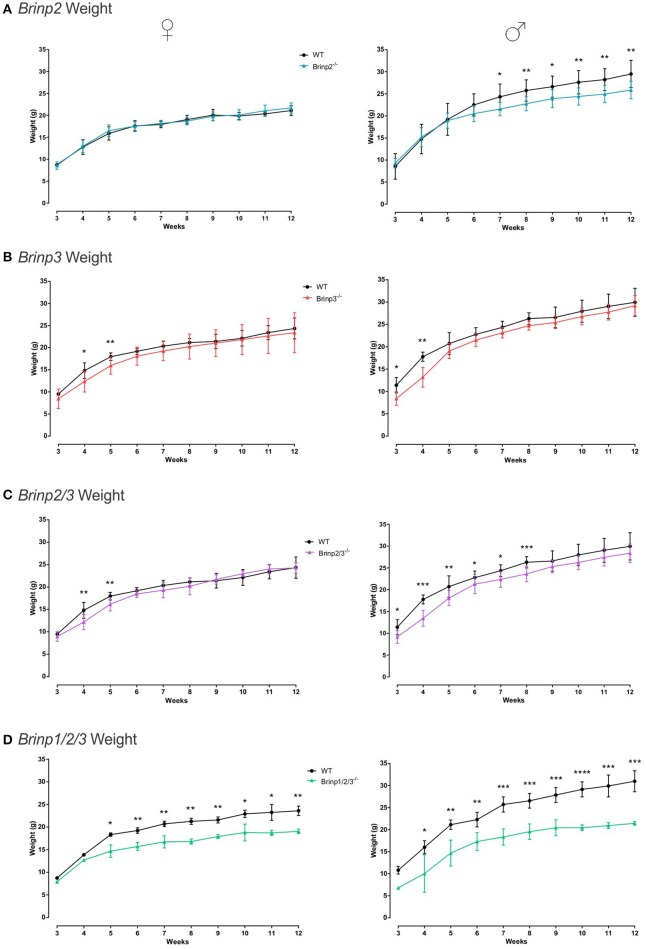
Brinp2, Brinp3, Brinp2/3, and Brinp1/2/3 weights. (A)
Brinp2−/− mice weighed from week 3 to 12. Female Brinp2−/− mice show normal weight between 3 and 12 weeks by repeat measures two-way ANOVA: F(1, 15) = 0.155, p = 0.699. Male Brinp2−/− mice show a significant reduction in body weight from 6 weeks of age onwards. By repeat measures two-way ANOVA male Brinp2−/− mice show a significant interaction of genotype × week: F(9, 117) = 5.645, p < 0.001. N = 8 females, 8 males per genotype. (B)
Brinp3−/− mice weighed from week 3 to 12. Both Male and Female Brinp3−/− mice show reduced body mass from weeks 3 to 5, before recovering to near normal weight from week 6 onwards. Female Brinp3−/− mice show a significant interaction of genotype × week: F(8, 96) = 2.115, p = 0.042, repeat measures two-way ANOVA. Male Brinp3−/− mice show a significant reduction in body weight to their littermates F(1, 12) = 8.602, p = 0.013, and a significant genotype × week interaction F(9, 108) = 3.919, p < 0.001, repeat measures two-way ANOVA. N = 7 females, 7 males per genotype. (C)
Brinp2/3−/− mice weighed from week 3 to 12. Female Brinp2/3−/− mice show a significant week × genotype interaction effect: F(9, 117) = 3.065, p = 0.002. Male Brinp2/3−/− mice show a significant decrease in body weight, analyzed by repeat measures two-way ANOVA: F(1, 14) = 6.228, p = 0.026, and a significant interaction effect between week × genotype: F(9, 126) = 2.461, p = 0.013. N = 8 females, 8 males per genotype. (D)
Brinp1/2/3−/− mice weighed from week 3 to 12. Female Brinp1/2/3−/− mice show a significant reduction in body weight: F(1, 3) = 47.738, p = 0.007, with a significant interaction between week × genotype: F(9, 27) = 5.736, p < 0.001, repeat measures two-way ANOVA, n = 3 WT, 2 Brinp1/2/3−/− mice. Male Brinp1/2/3−/− mice also show a significant decrease in body weight: F(1, 8) = 54.708, p < 0.001, with a significant interaction between week × genotype: F(8, 64) = 3.005, p = 0.006, repeat measures two-way ANOVA, n = 5 WT, 5 Brinp1/2/3−/− mice. Results represented as the mean ± SD.